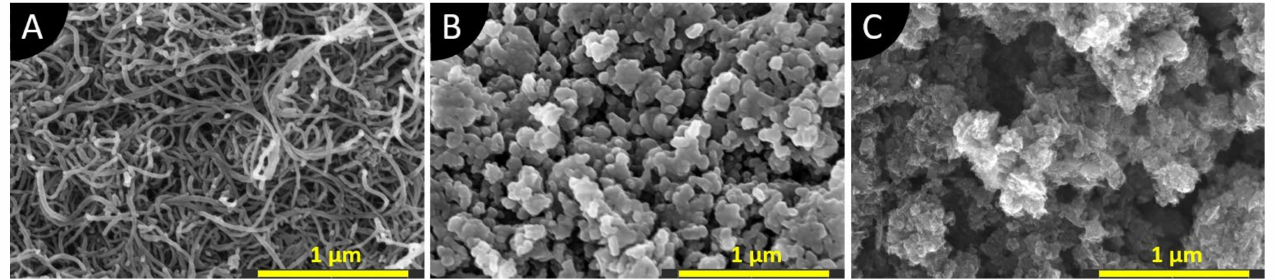
Figure 1. SEM images of as-received nanomaterials. Magnification 150,000 × : ( A ) MWCNT-COOH; ( B ) Printex XE2 B Beads®carbon black; ( C ) Graphene nanoplatelets (CP-0081-HP-0100).